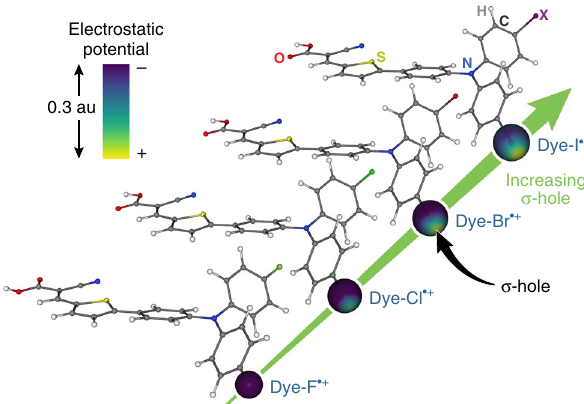
Fig. 4 Landscape of energy levels. Summary of the ground-state and excited-state reduction potentials for the Dye-X series, relevant redox couples for an iodine-based electrolyte, and rate constants for electrolyte charge recombination ( k CR ), back-electron transfer ( k BET ), and dye regeneration ( k reg ). All potentials are reported in V vs. NHE. The numbered reactions correspond to Eqs. 1 – 5